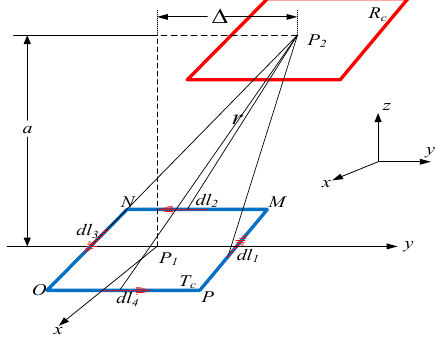
Figure 3. Square geometry coil set.